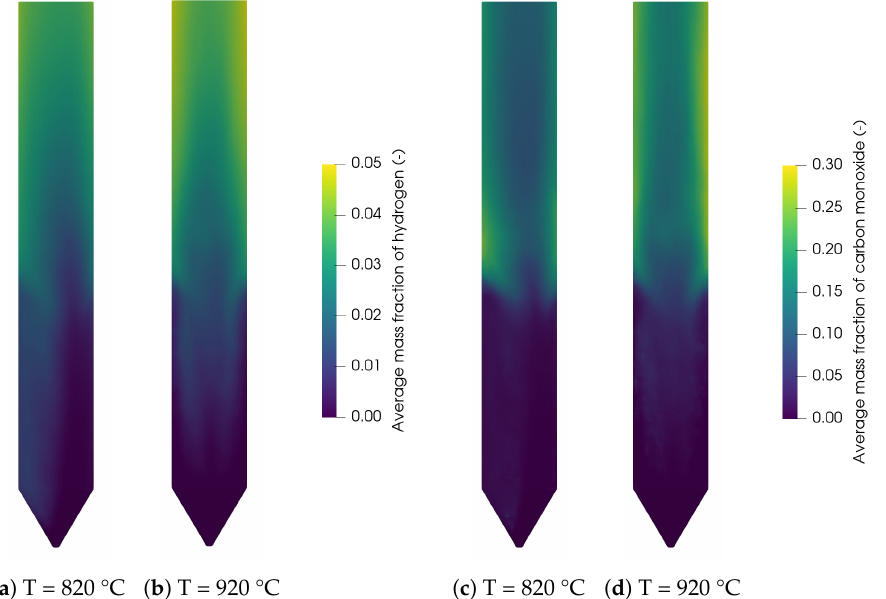
Figure 9. Contour plots of hydrogen at ( a ) 820 °C and ( b ) 920 °C, and carbon monoxide at ( c ) 820 °C and ( d ) 920